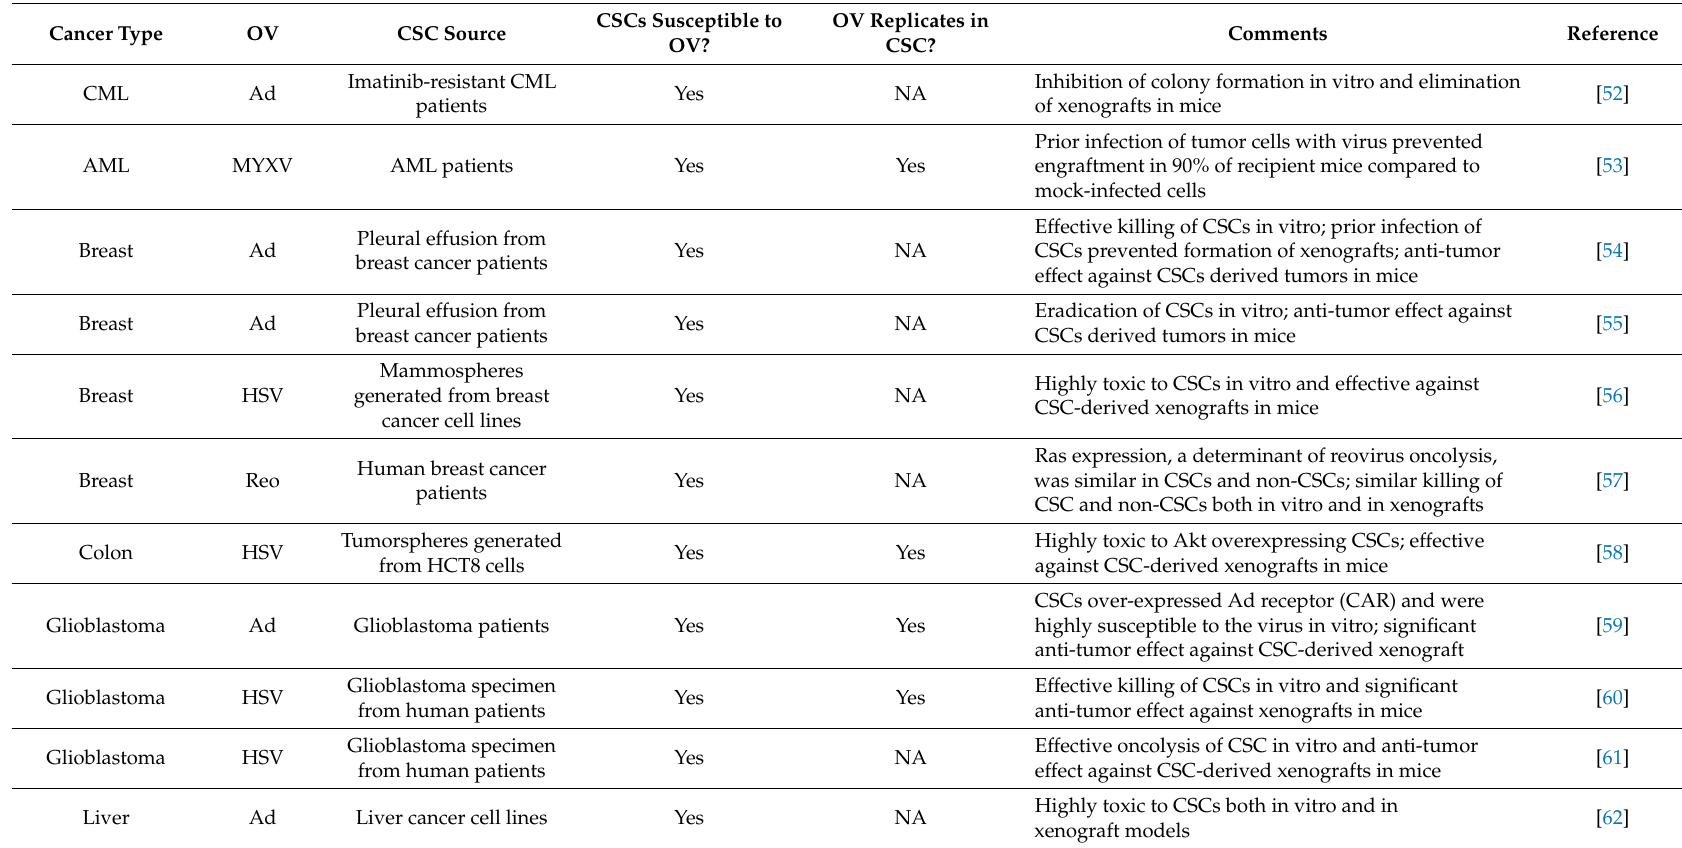
Table 1. Examples of oncolytic viruses (OVs) that are effective against CSCs of different